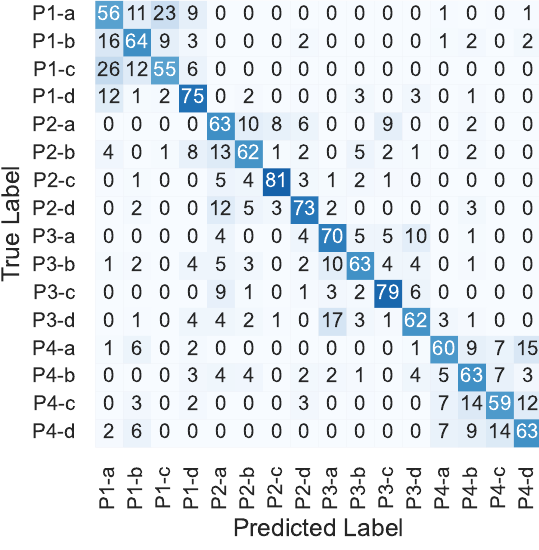
Figure 7. Confusion matrix of one-step recognition method [%].